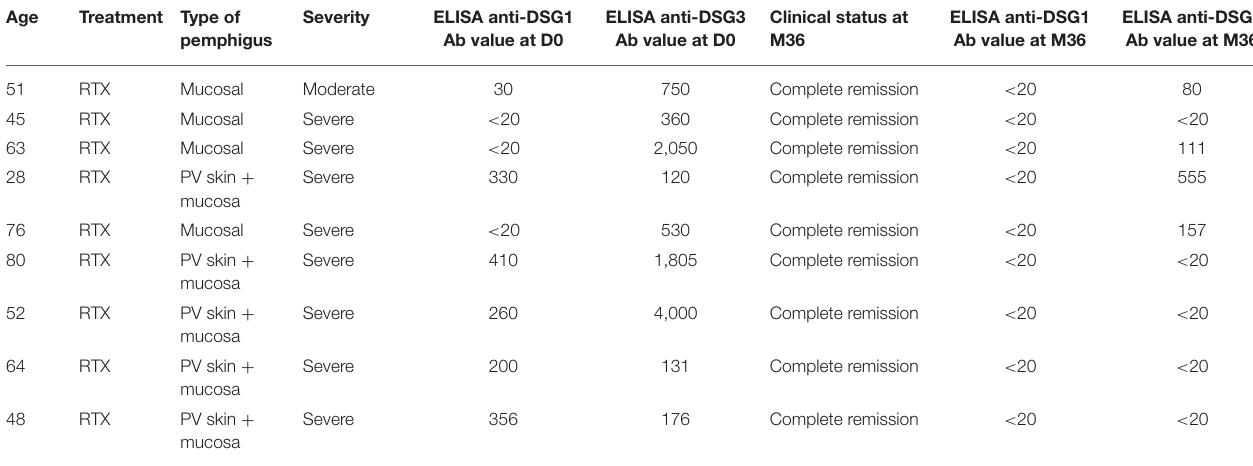
TABLE 2 | Clinical and biological characteristics of patients from the standard corticosteroids (CS) group. Age Type of Severity ELISA anti-DSG1 ELISA anti-DSG3 pemphigus Ab value at D0 Ab value at D0